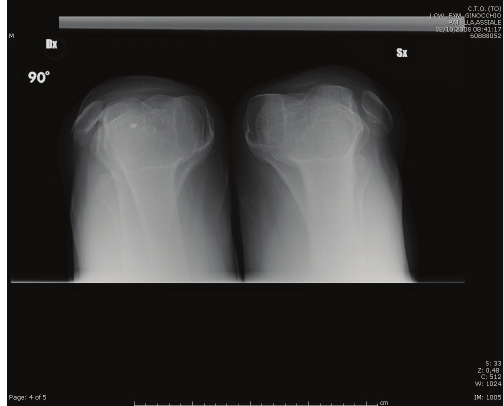
Figure 5: Skyline view roentgenograms, showing an increased deep of the trochlear groove and laterally dislocated